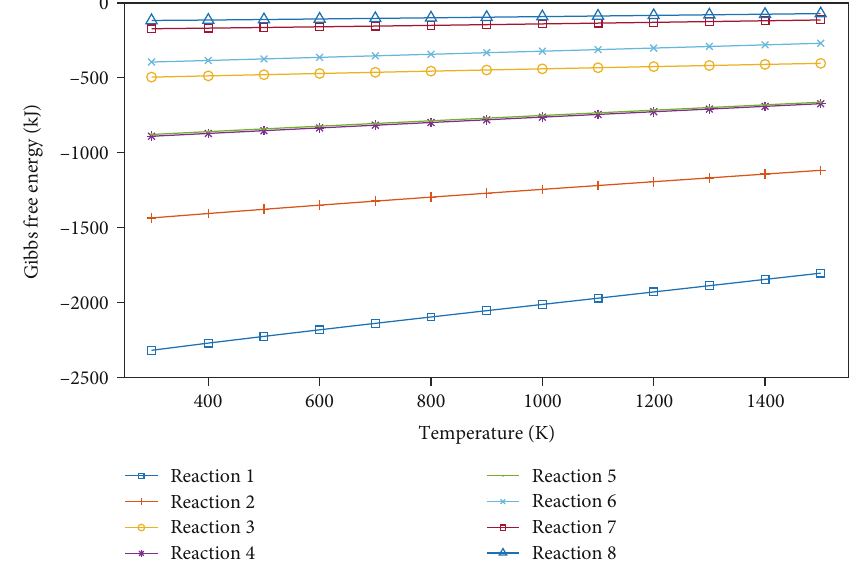
Figure 3: Variation of Gibbs free energy at di ff erent